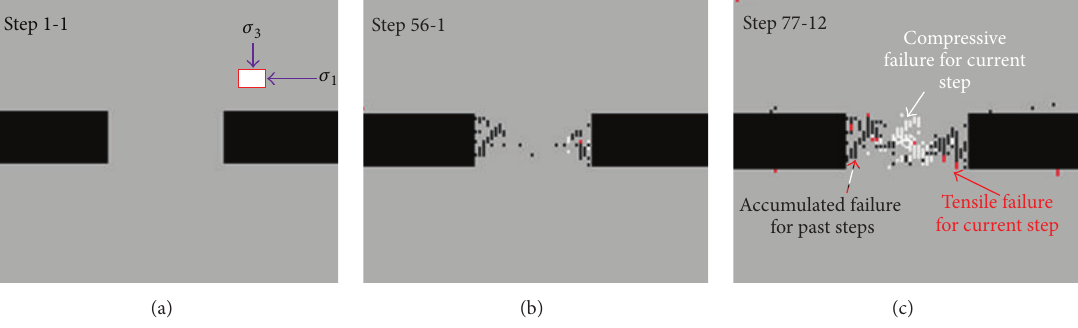
Figure 14: Plot of acoustic emissions for a pillar with width-to-height ratio = 2.0.